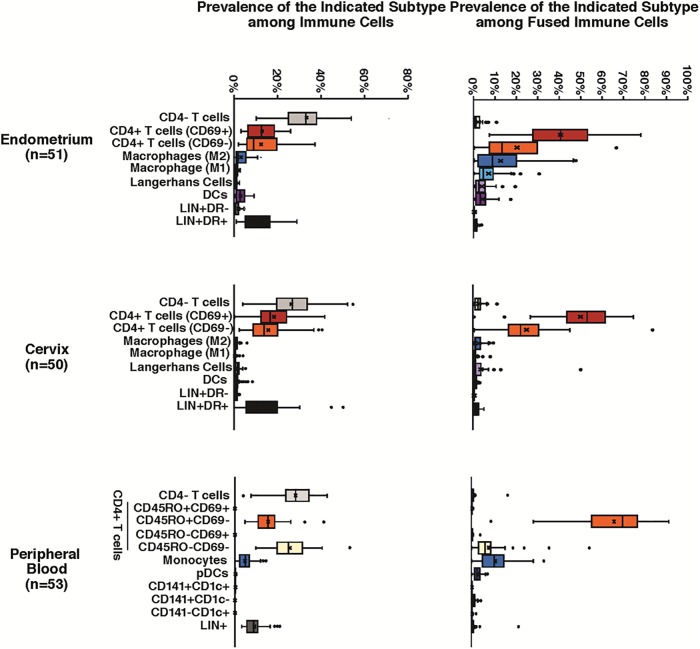
Distribution of cellular subsets in total and fused immune cells from 3 anatomic locations.Single-cell suspensions from endometrium (n = 51), cervix (n = 50), and peripheral blood (n = 53) were infected with ZM247v2 HIV-1 virions containing BlaM-Vpr. All infections were performed simultaneously for a given anatomical site. After 1.5 h of infection the fusion assay was conducted. Box plots are used to describe the distributions of immune cells (left) and fused immune cells (right) for 11 cellular subsets per sample location. The line through the box represents the median, and the x represents the mean; whiskers on the box plots represent the 255h and 75th percentiles; outliers are indicated with black circles.